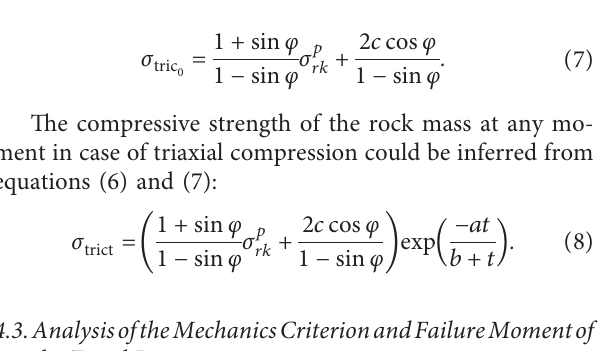
Figure 8: Relaxation curve of rock mass on the elastic-plastic